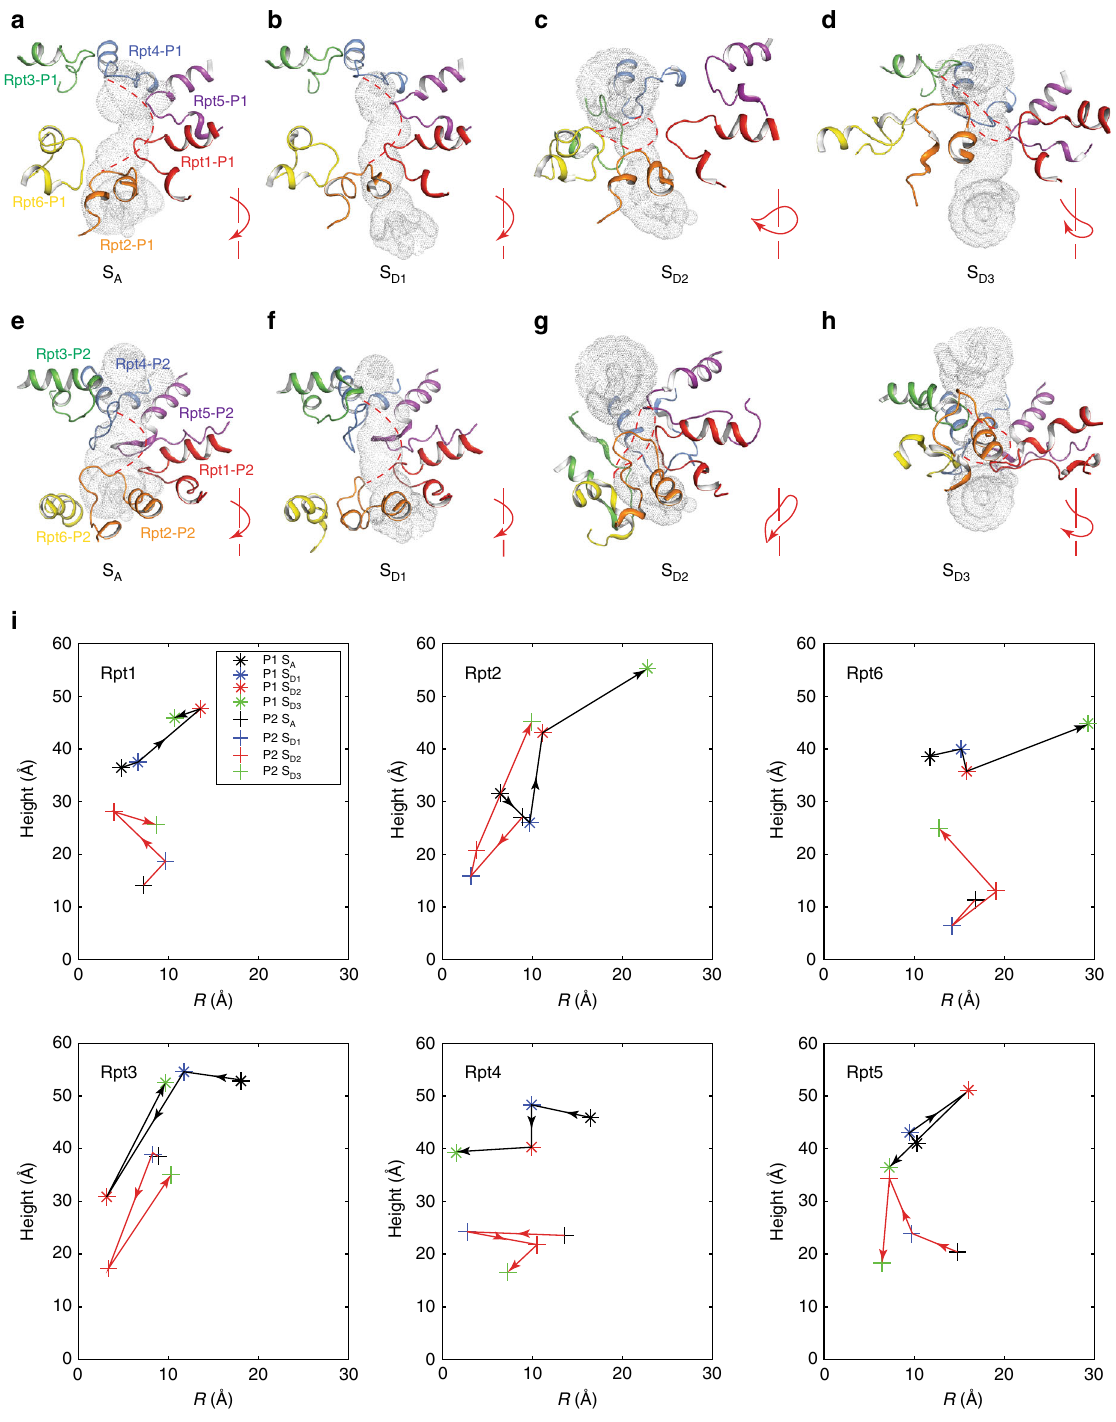
Fig. 6 Topological remodeling of the pore loops along the substrate – translocation channel. a Close-up view of the pore-1 loops from six Rpt subunits constricting the AAA channel in the S A state. The solvent accessible surface of the AAA channel was estimated using the program HOLE and is shown in gray dots. The AAA channel is aligned top-down vertically, whereby the substrates are supposed to enter from the top end of the pathway. b – d Close-up views of the pore-1 loops from six Rpt subunits constricting the AAA channel in the S D1 , S D2 , and S D3 states. The lower right inset in each panel shows an illustrative graph summarizing the pore-1 loop organization topology. The arrows show the clockwise direction of oligomeric ATPase organization from Rpt3, through Rpt4, Rpt5, Rpt1, and Rpt2, to Rpt6. The pore-1 loops in S D2 and S D3 show saddle-like topologies versus the spiral topology in S D1 and S A . The AAA channels are aligned to that shown in a based on their positions relative to the common reference of the CP. e Close-up view of the pore-2 loops from six Rpt subunits decorating the AAA channel in the S A state. f-h , g Close-up view of the pore-2 loops from six Rpt subunits constricting the AAA channel in the S D1 , S D2 , and S D3 states. i The relative positional changes of each pore loop in the S A , S D1 , S D2 , and S D3 states. The arrows show the direction of the movements in the pore loops during state transitions from S A to S D1 ( f ), S D2 ( g ), and S D3 ( h ), respectively. The vertical axis indicates the relative height of the pore loops along the axis of the ATPase channel and the CP gate. The horizontal axis indicates the lateral distance orthogonal to the channel